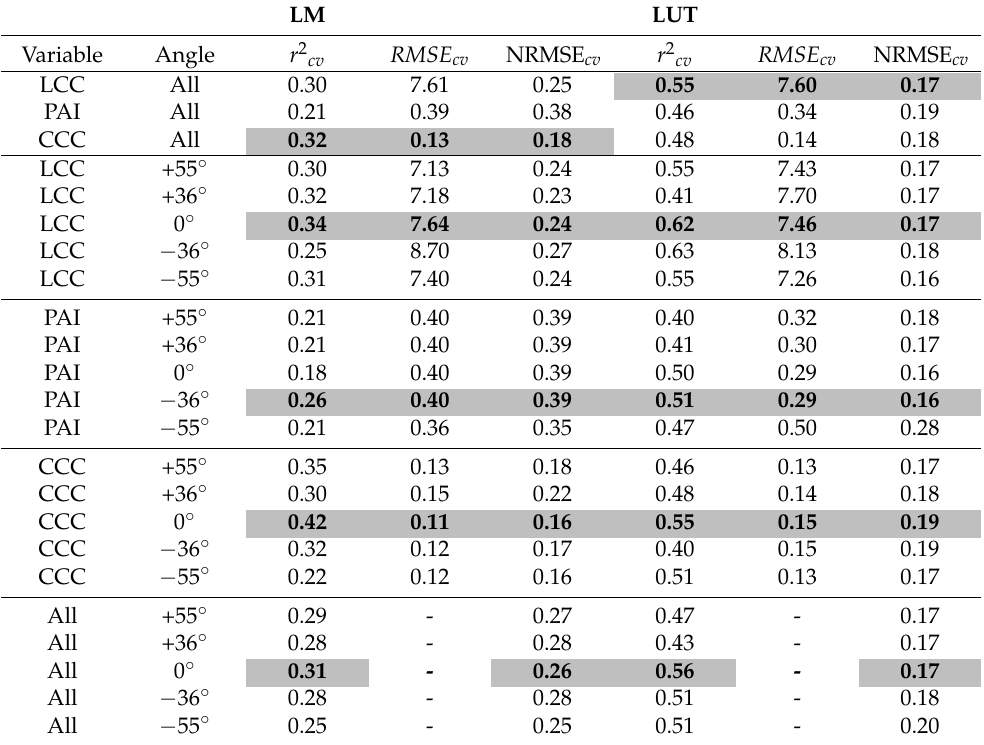
Table 4. Global PROSAIL model performance for Levenberg–Marquardt (LM) and look-up table (LUT) inversions for combined field sites. Root mean square error (RMSE) units: leaf chlorophyll content, LCC ( µ g/cm 2 ); plant area index, PAI (m 2 /m 2 ); canopy chlorophyll content, CCC (g/m 2 ). Normalized root mean squared error (NRMSE) = RMSE/range of measured data. The best results are shown highlighted and